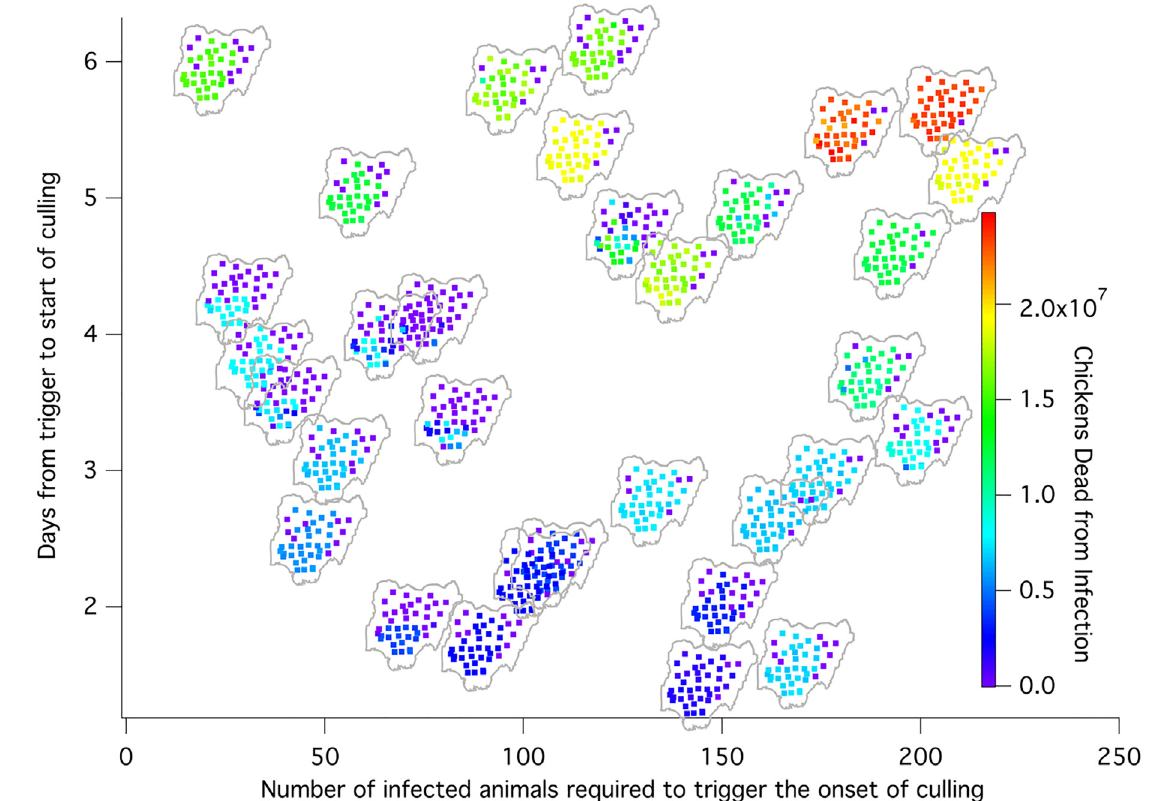
Fig 3. The impact on the total number of chickens that died from infection as the two most significant simulation parameters are varied, the time before initiation of culling vs. the number of infected animals required to trigger the onset of culling. The maps are color-coded for the number of chickens dead from